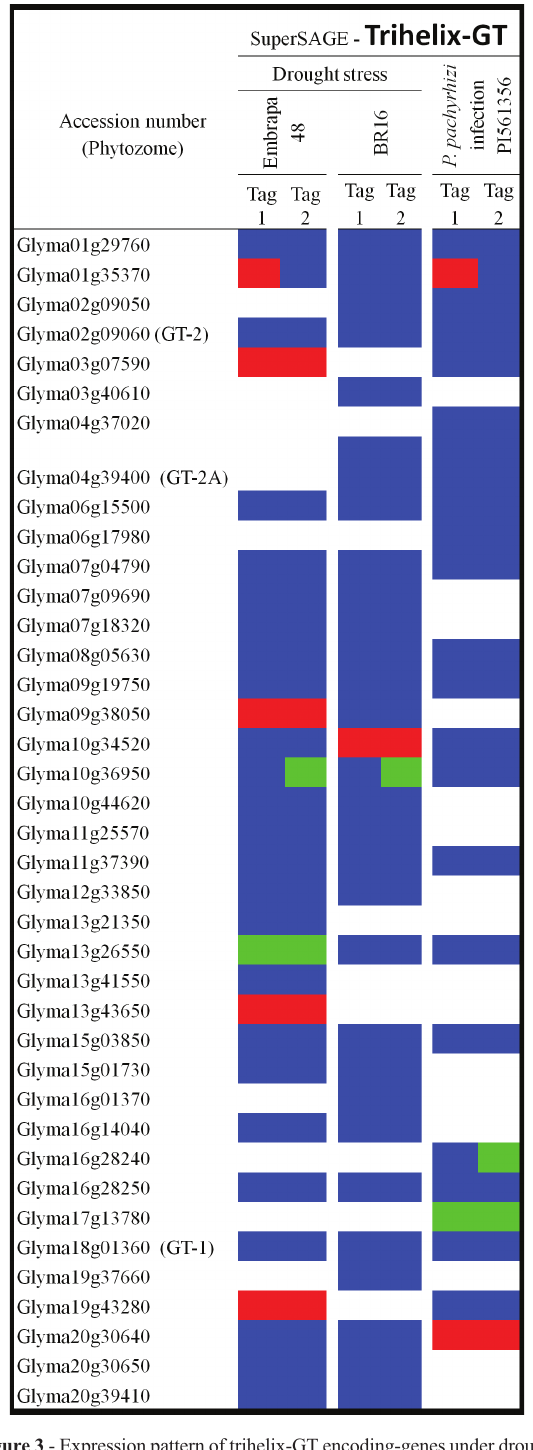
Figure 3 - Expression pattern of trihelix-GT encoding-genes under drought stressand P.pachyrhizi infection.Theexpressiondatawereobtainedfrom superSAGE experiments available at www.lge.ibi.unicamp.br/soja/. Blocks indicate up-regulation (red), down-regulation (green), non-signi- ficantdifferences(p>0.05)butexpressiondetected(blue),andexpression not detected (white). Contrasting expression might reflect detection of a single gene by different tags. Drought stress was carried out in roots from Embrapa-48 (tolerant cultivar) and BR 16 (susceptible cultivar). Soybean leaves from PI561356 (resistant genotype) were infected with P. pachyrhizi